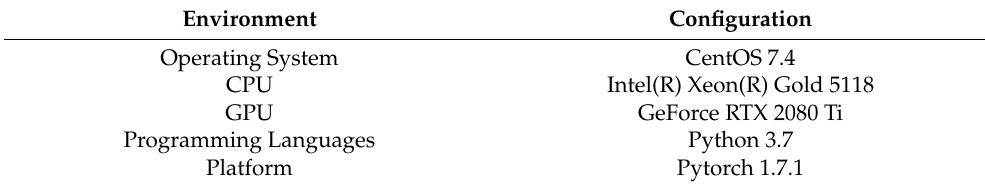
Table 7. Experimental